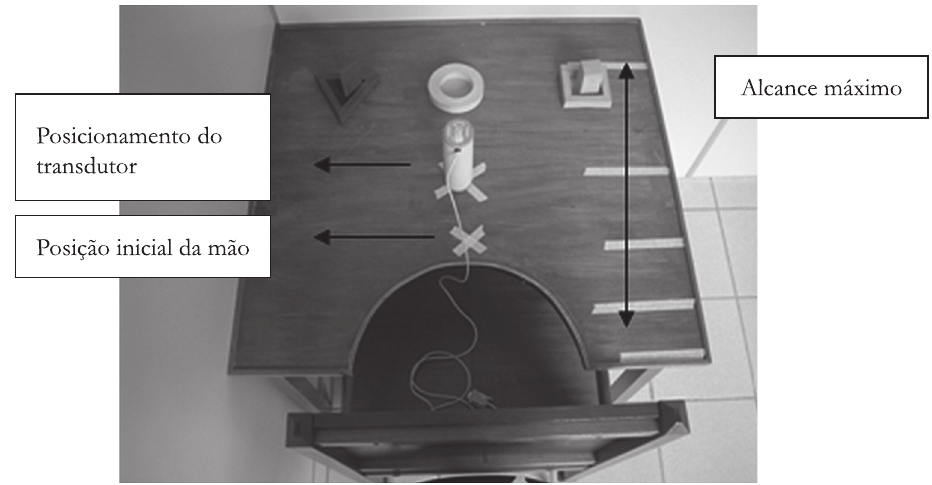
Figura 1 - A disposição dos objetos; posicionamento inicial da mão; posicionamento do transdutor; alcance máximo do participante (ponto final para encaixe do transdutor de